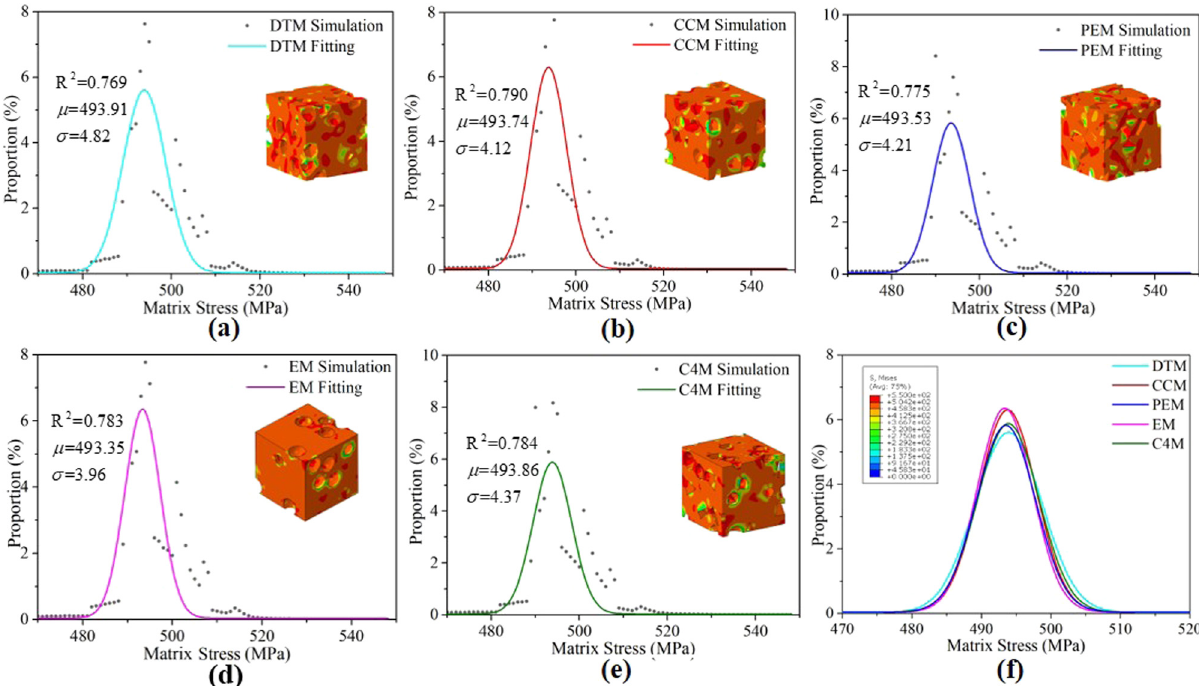
Figure 10: Matrix micro - stress distribution at a tensile strain of 1%: ( a ) DTM, ( b ) CCM, ( c ) PEM, ( d ) EM, ( e ) C4M, and ( f ) fi t